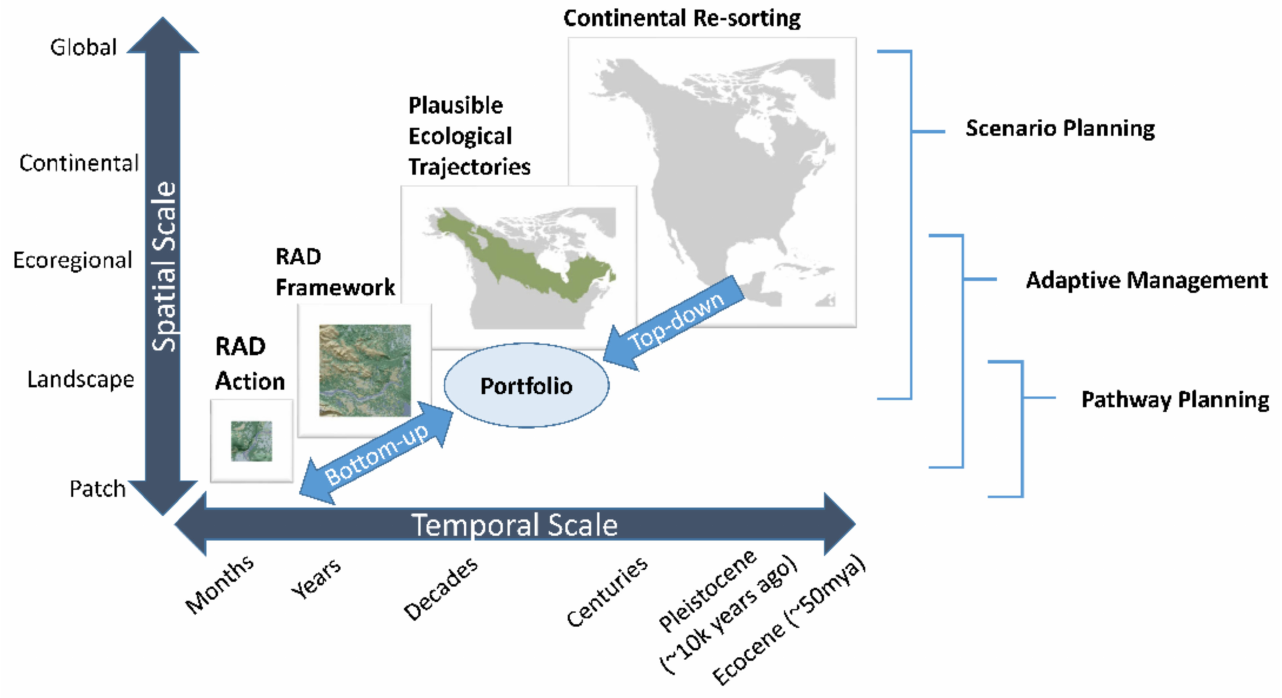
Figure 2. Blueprint for building a decision context to implement climate change adaptation on National Wildlife Refuges in the United States. The blueprint integrates multiple spatial and temporal scales, management considerations (continental resorting, plausible ecological trajectories, the RAD framework, and RAD actions), and assessment approaches (scenario planning, adaptive management, and adaptive pathway planning). The management considerations are needed to understand what future conditions are possible, how intervention can be used to shape future conditions, and to coordinate regional conservation strategies. Portfolios consist of suites of RAD strategies that are being applied in different places. Local RAD actions can be informed by and coordinated into (bottom-up arrow) a portfolio that can also be informed by regional climate vulnerability (top-down arrow). Scenario planning can be applied at large spatial scales, while adaptive management is applied at regional, landscape, and local scales. Pathway planning is context dependent and best applied at landscape and local